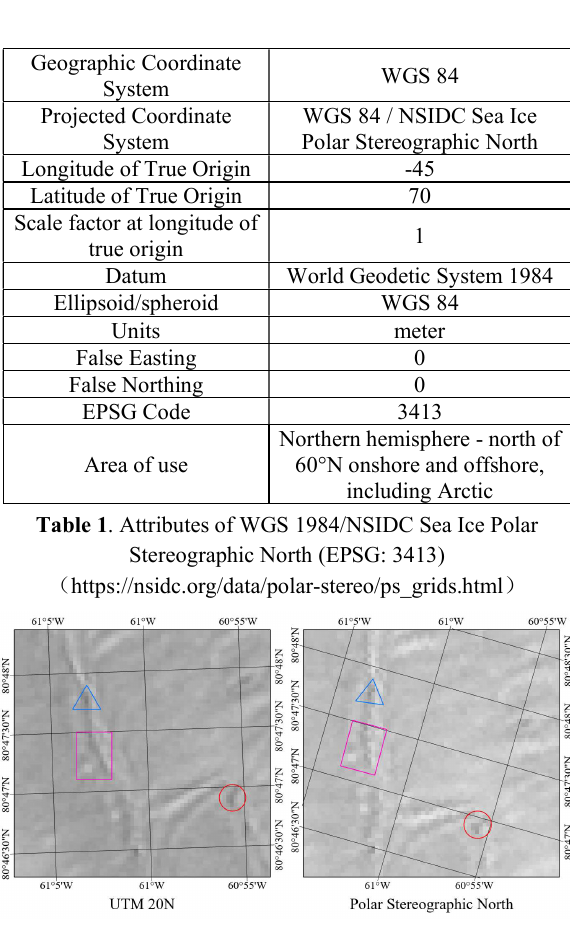
Figure 1 . The original image coordinate system is UTM 20N, and the image after reprojection is Polar Stereographic